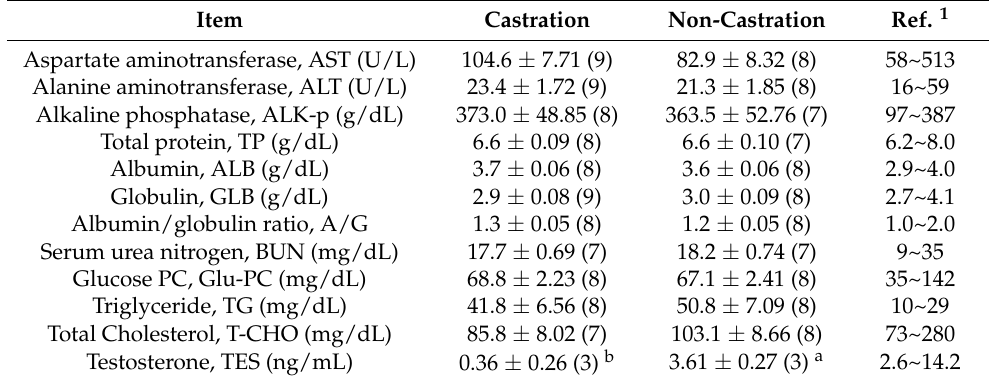
Table 4. Effects of castration and non-castration on serum blood biochemistry parameters of Nubian crossbred male goats at 25 weeks old (LSM ± SE).